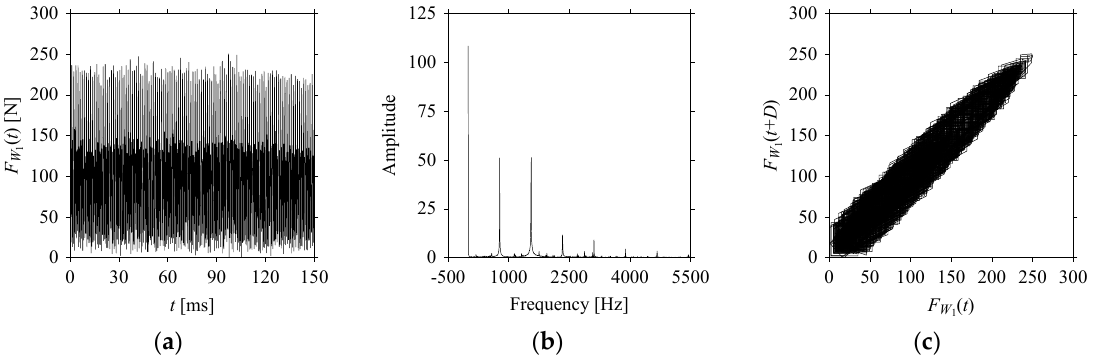
( a ) ( b ) ( c ) Figure 8. F W in the form of: ( a ) time series, ( b ) fast Fourier Transformation (FFT), and ( c ) delay map ( d = 1).